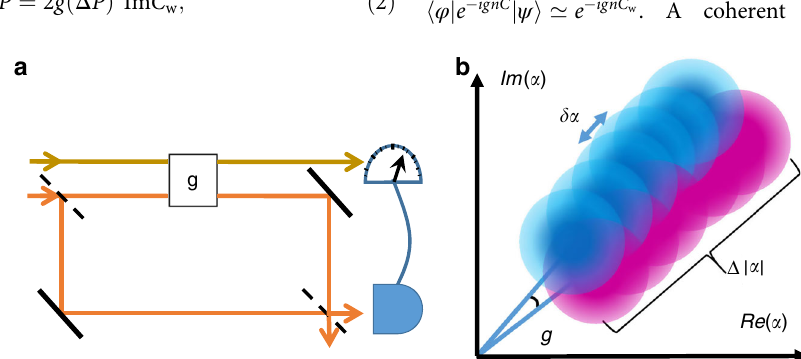
Fig. 1 Strategies for precision measurements. a The scheme: a single-photon goes through an interferometer, where in one arm it interacts with a coherent state and a phase is acquired, while in the other nothing happens. At the exit port the two paths interfere so the probability of the photon coming out there depends on the phase it acquired by the interaction, and thus, also on the number of photons in the probe. Post-selecting the probe pulses accordingly induces a shift in the average photon number, from which the interaction strength can be estimated. b The principle of our method: a statistical ensemble of α j i (only a few are drawn), showing the two paths for each member: blue with the phase and magenta without. Due to the probability of postselection, Eq. (3), the ensemble is shifted in the radial direction. The shift in photon number, Eq. (5), δ n ∝ ( Δ n ) 2 ∝ N 2 so the shift in α j j is ∝ N 3/2 . The uncertainty in n can be fl uctuated to be ∝ N . The ratio between the uncertainty and the shift is ∝ 1/ N , resulting in the Heisenberg